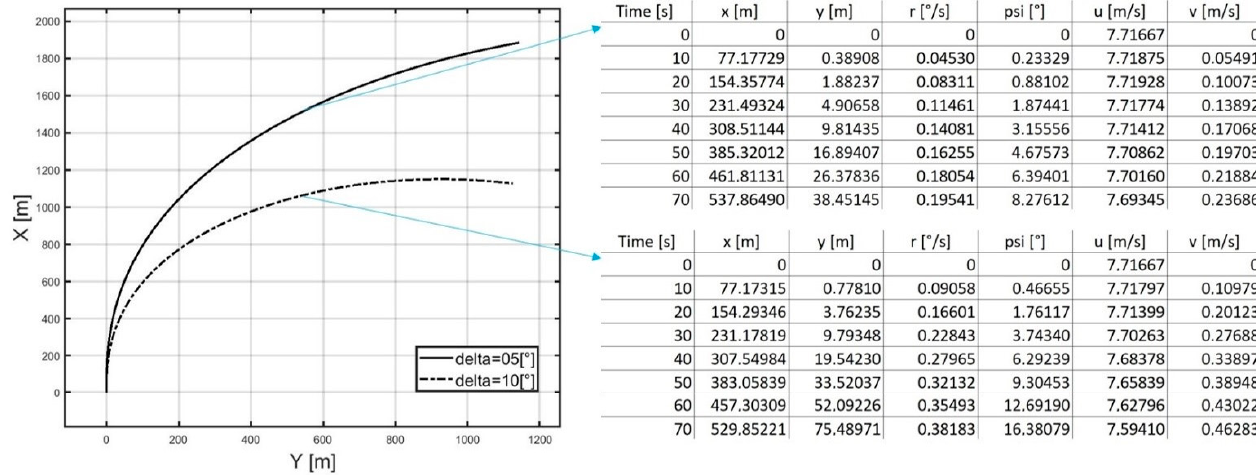
Figure 2. Example table fragments obtained from turning circle tests performed for the same starting conditions and varying rudder settings ( δ = 5 ◦ , δ = 10 ◦ )